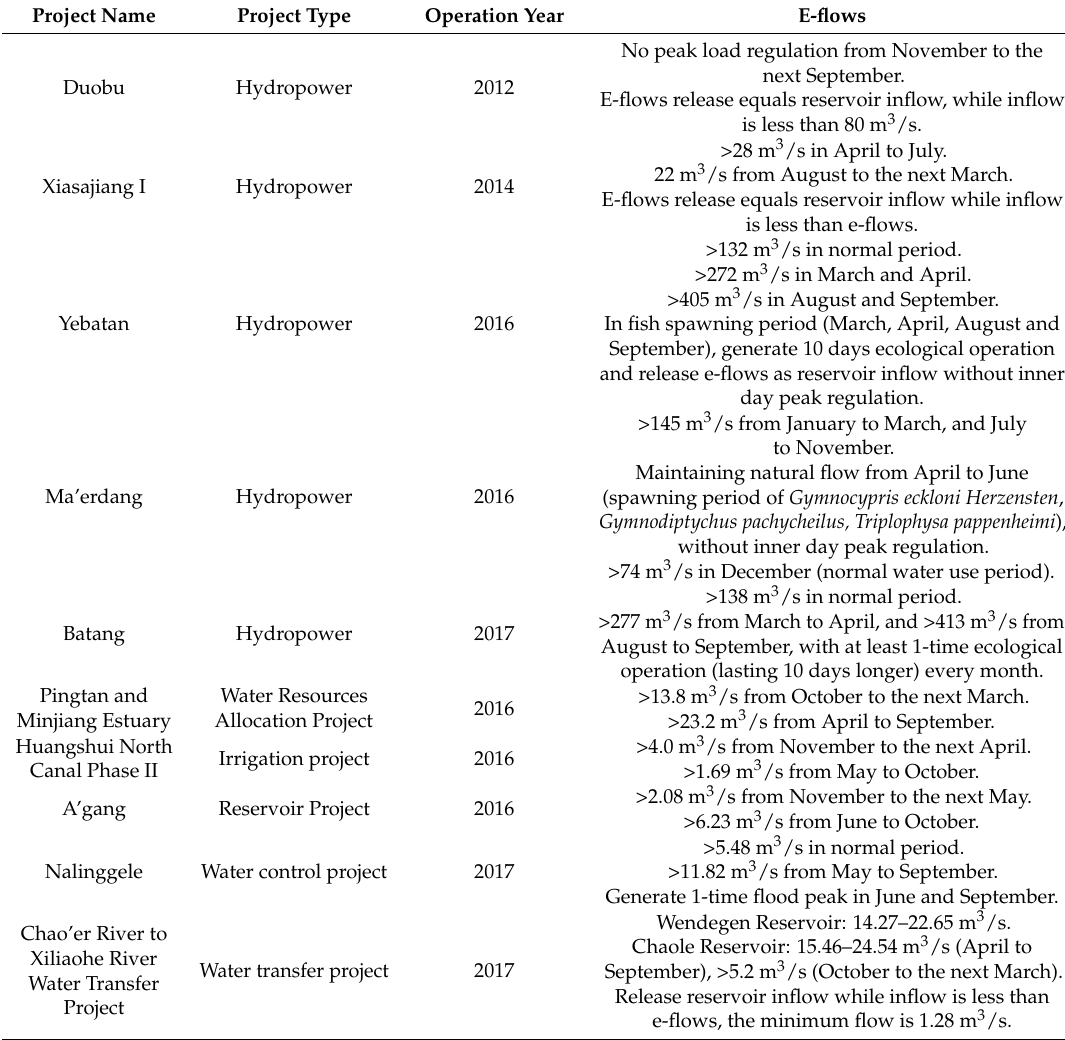
Table 3. E-flows validation practices of hydropower and water conservancy